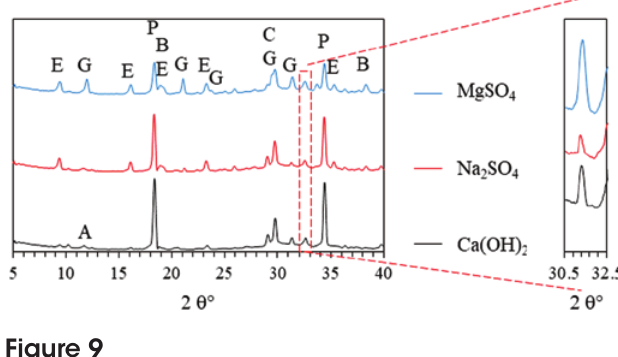
Figure 7 Comparative pH analysis of Ca(OH) and MgSO solutions over 20 weeks (140 days) 4